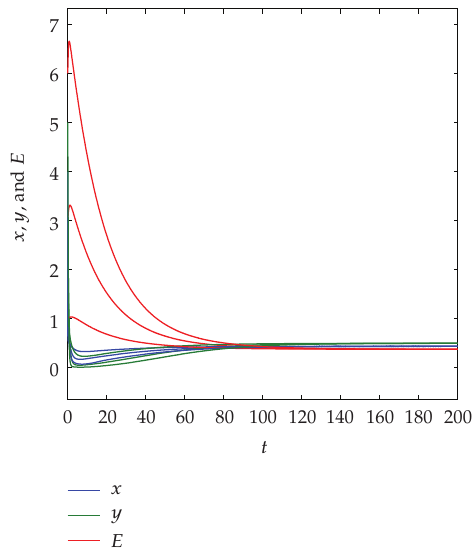
Figure 7: Solution curves of system (cid:6) 4.1 (cid:7) with the parameters given by Example 6.2 when r 1 (cid:8) 10.